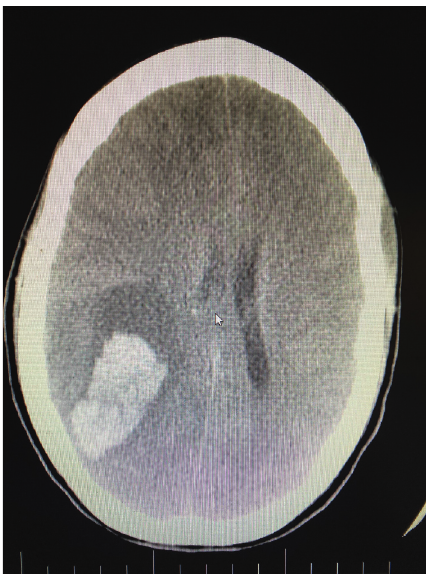
Figure 1: Computerized tomography (CT) axial head without contrast showing intraparenchymal hemorrhage and secondary mass effect.